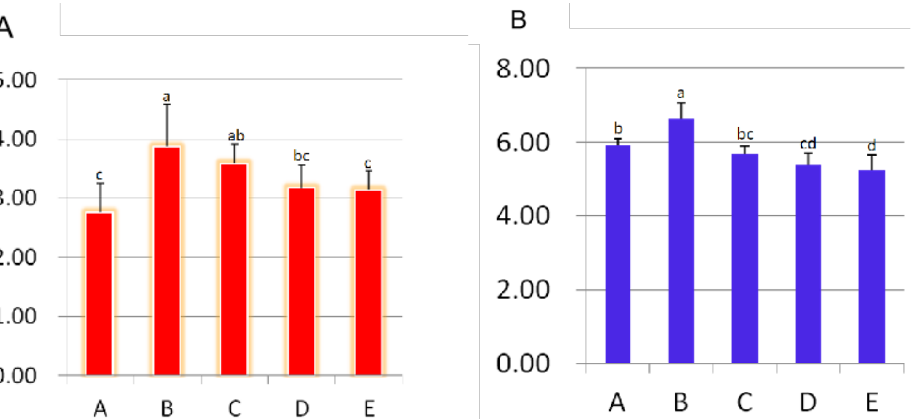
Figure 1. ( A ) Effects of different GSP groups on the adiposity coefficient of rats. ( B ) Effects of different GSP groups on daily weight gain of rats. Values of different groups with small superscripts mean significantly different ( p < 0.05).